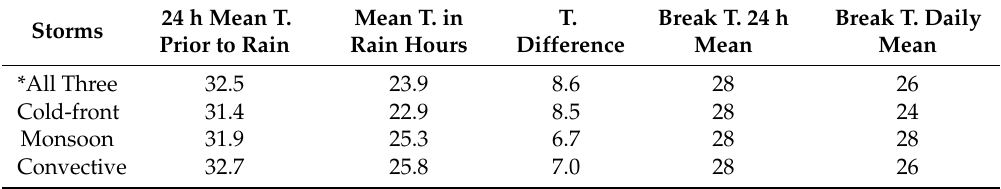
Table 4. Mean air temperature (T. = ◦ C) 24 h prior to the storms and during the storms, and the break air temperature of the scaling rates using the 24-h mean and natural daily mean temperature at the 42 automatic weather stations from July 2015 to October 2017. *All storms only include the three types of